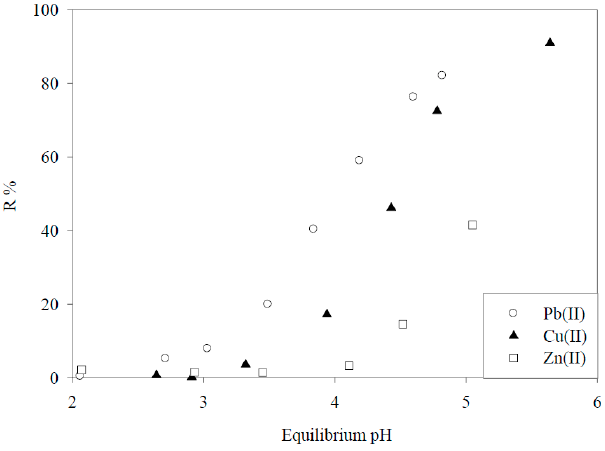
Figure 8. Adsorption of Pb(II), Zn(II) and Cu(II) by DIAION WK11 resin as a function of the equilibrium pH [9]. (With permission for reuse from Elsevier B.V.).